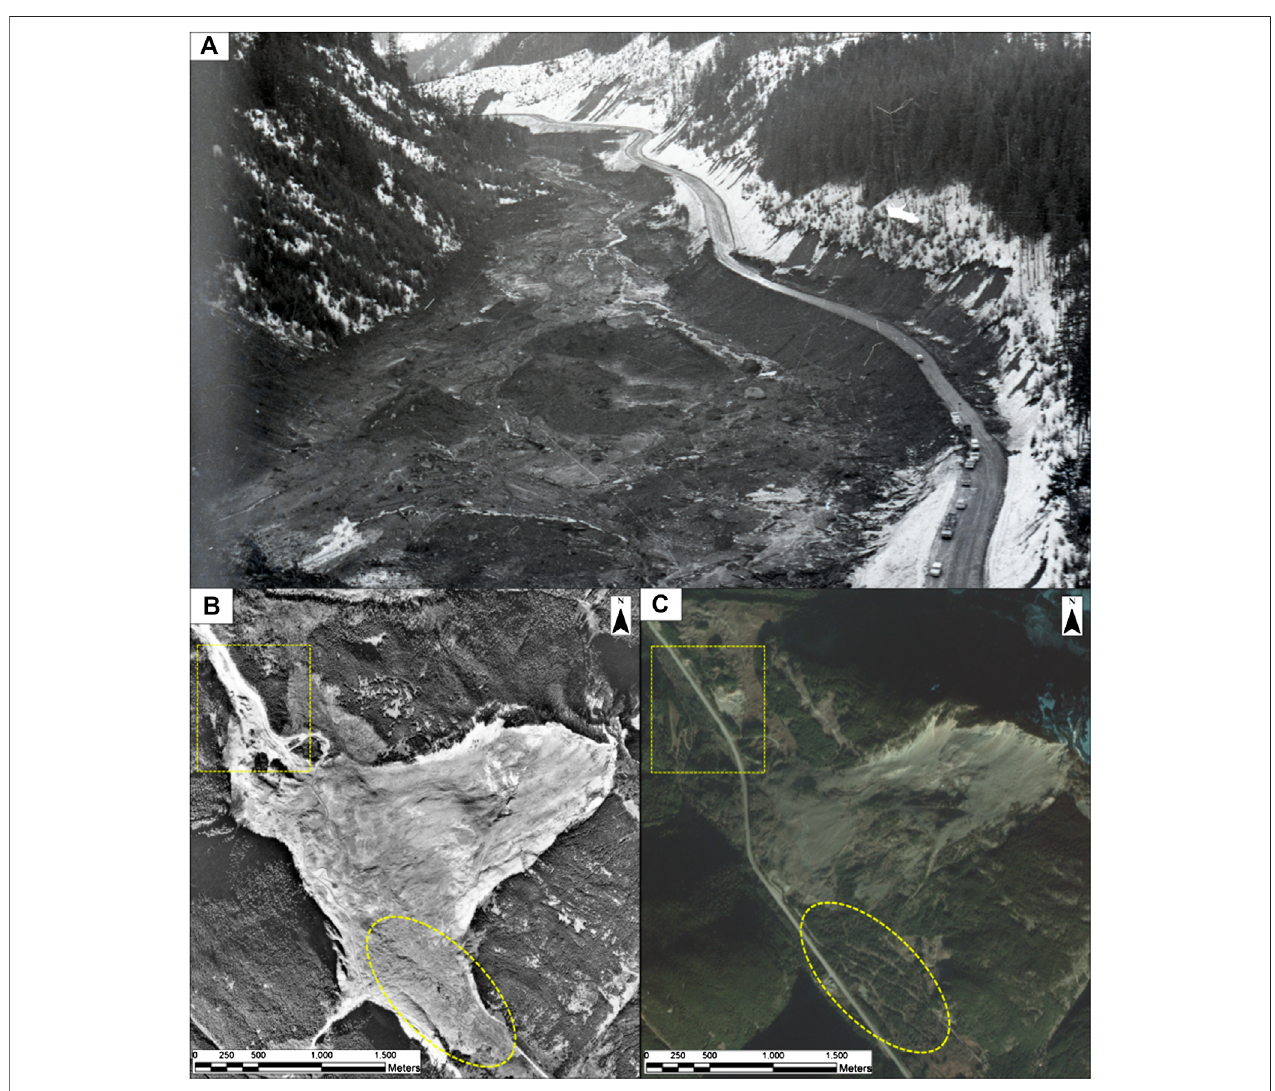
FIGURE 2 | (A) Rock avalanche-generated mass fl ow impact area (splash zone) at the northern margin of the Hope Slide [photo taken shortly after the event in January 1965, courtesy of British Columbia Ministry of Transportation and Infrastructure (BC MoTI)], (B) orthorecti fi ed airphoto of the impact area from 1965, and (C) orthorecti fi ed satellite image of the same area from 2019 (Planet, 2020).The approximate area shown in Panel (A) isindicated by the yellow rectangles in Panels (B) and (C) . The yellow oval highlights the revegetation of the Zone 2 impact area at the southern margin of the deposit.